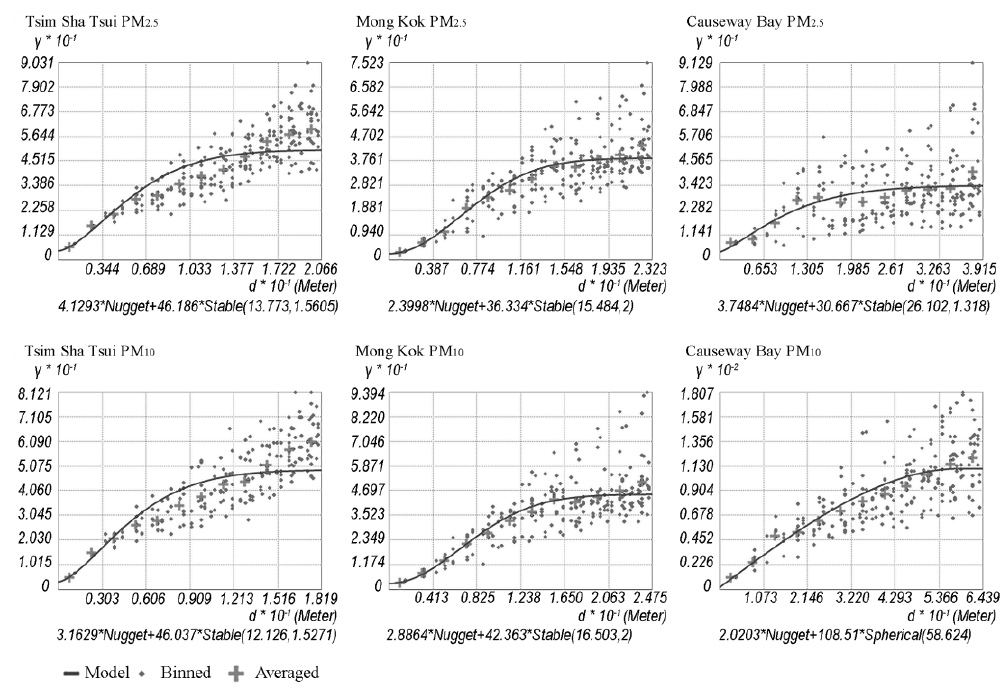
Figure 4. The six resultant semivariogram models established for PM 2.5 and PM 10 of the three study areas.